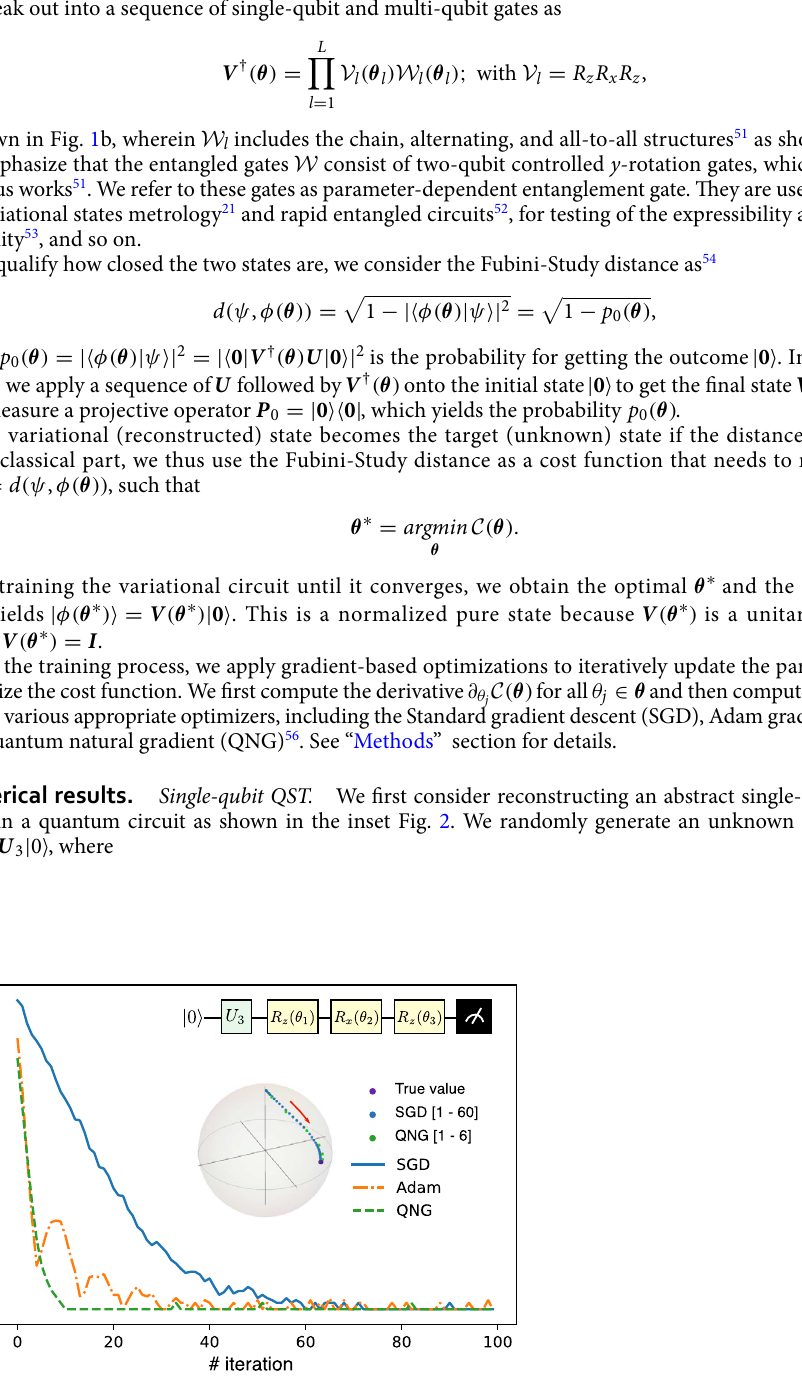
Figure 2. Single-qubit tomography. Cost function versus the number of iterations for difference optimizers: SGD (blue), Adam (orange), and QNG (green). Inset 1: quantum circuit for a single-qubit tomography where an unknown qubit state is generated by a random unitary U 3 (θ , φ , (cid:31) ) , and V † ( θ ) is made up of R z (θ 1 ) , R x (θ 2 ) , and R z (θ 3 ) gates. Inset 2: Bloch sphere represents the qubit states: violet circle: the true state, blue circle: the trajectory of the reconstructed state under the SGD optimizer for the iterations run from 1 to 60, green circle: the trajectory under the QNG optimizer for the iteration runs from 1 to